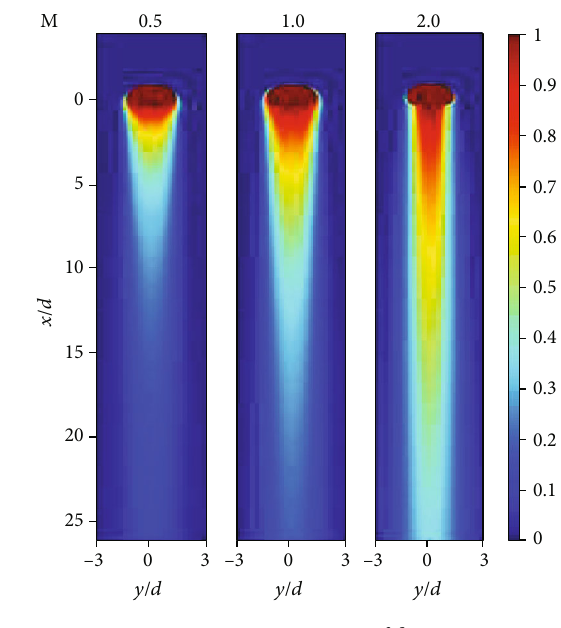
Figure 14: CFD contours of θ = 14 °